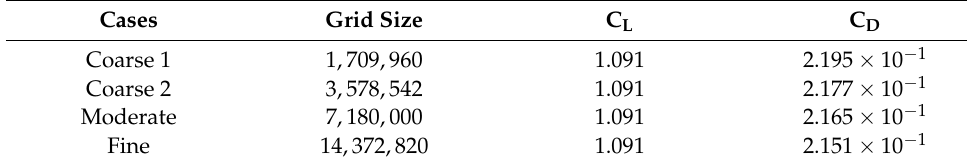
Figure 5. Grid system of the waverider. Table 1. Grid independency analysis results.